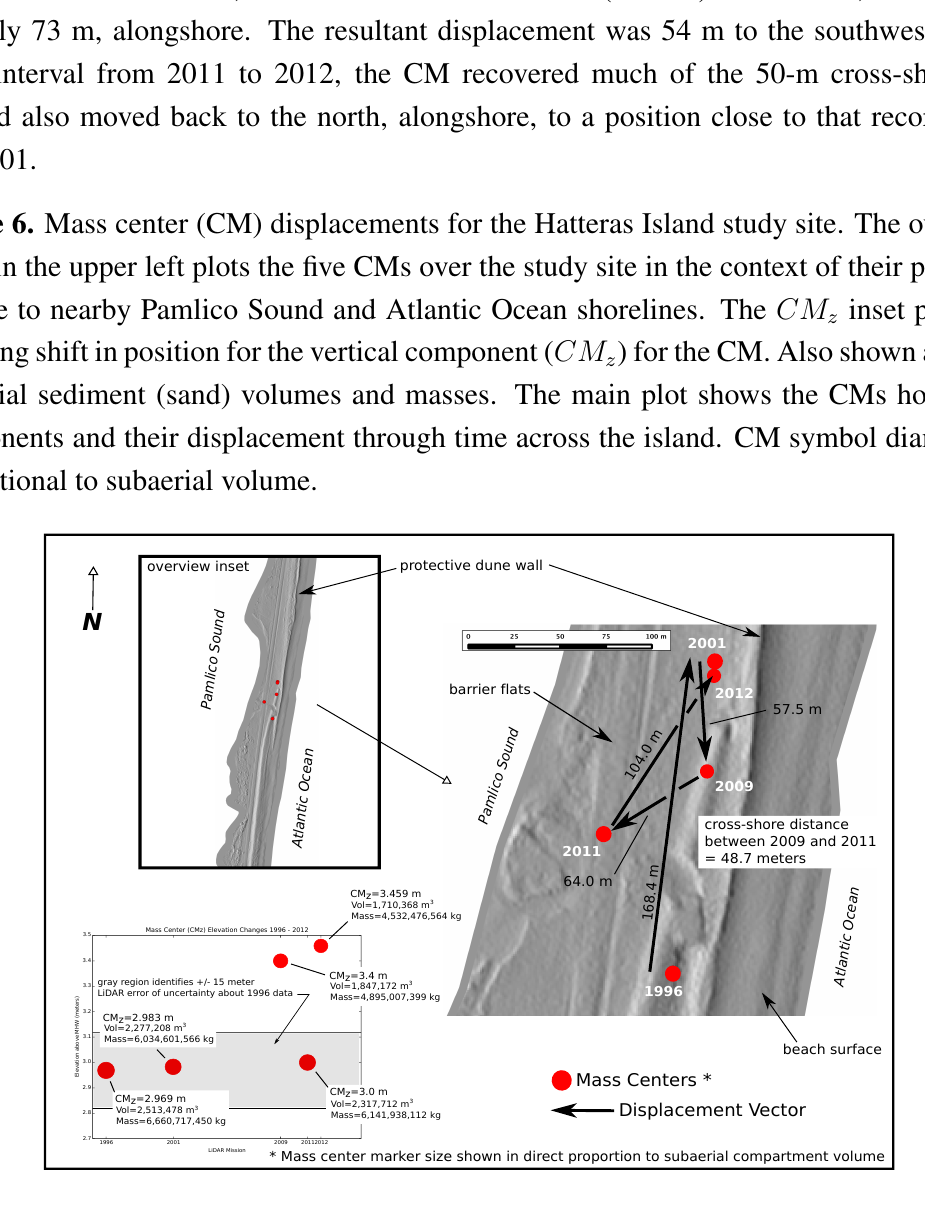
inset plots the z ) for the CM. Also shown are total z